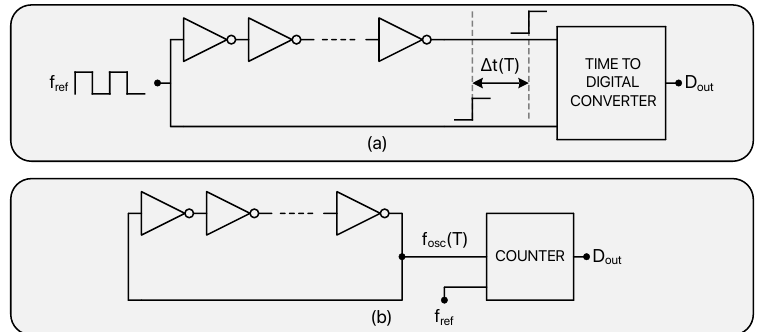
Figure 4. Main circuits that exploit the temperature dependency of the propagation time of CMOS inverters to achieve a Temperature-to-Digital conversion: delay line based TDC ( a ), ring oscillator based TDC ( b ).